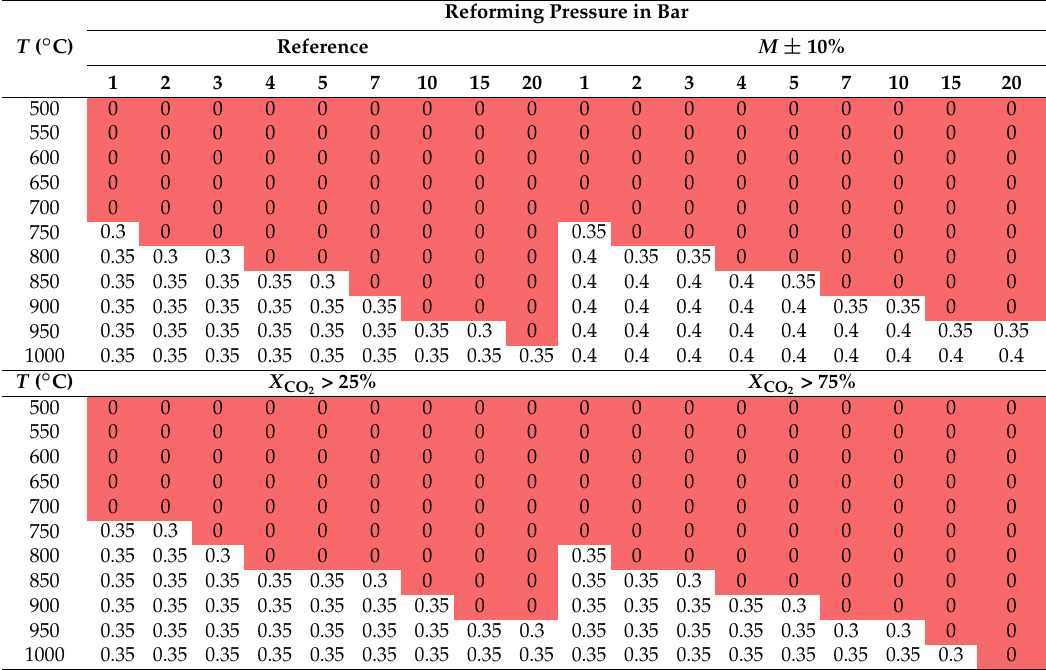
Table 10. Results of sensitivity study, maximum possible CO 2 /CH 4 ratio at the reactor inlet.